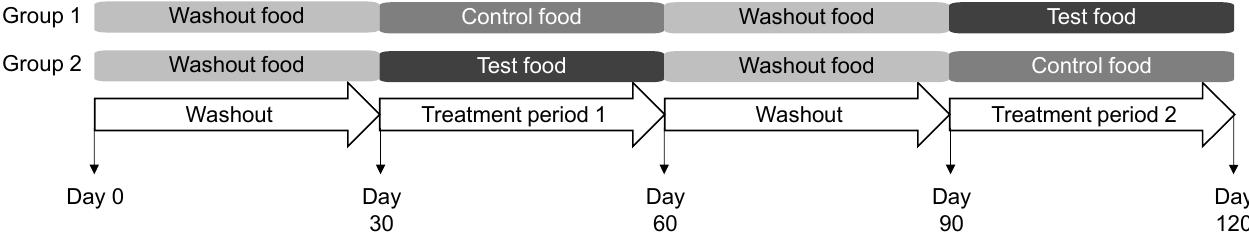
Control food food